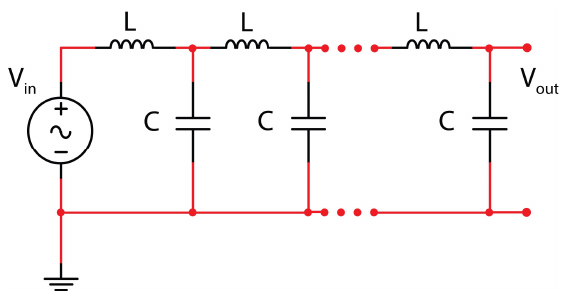
Figure 2. Ladder network formed by n-L–C elementary cells.